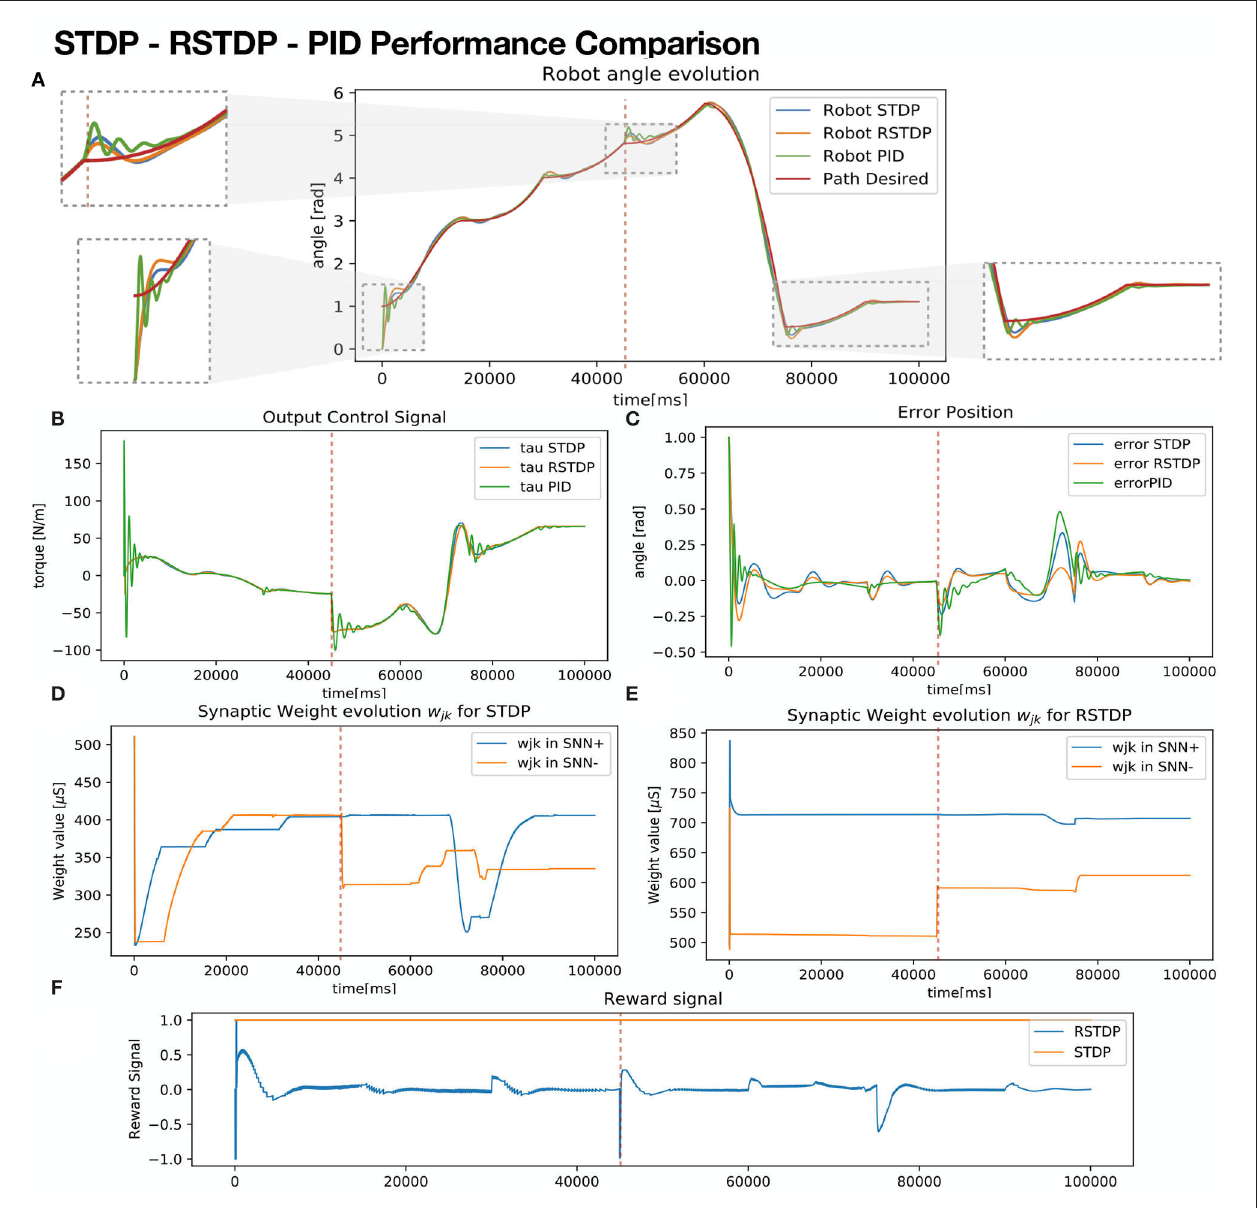
FIGURE 6 | 1-Link robot controller performance comparison. (A) Robot Angle evolution for each robot, SNN-RSTDP: with R jk = tanh ¨ q e (Yellow), SNN-STDP: proposal with R jk = 1 (Blue), PID-Controller tuned with Ziegler Nichols (Green), compared against reference (Red). (B) Control output of each controller. (C) Error position: difference against the reference. (D) Synaptic weights evolution for constant reward robot (SNN-STDP). (E) Synaptic weight evolution for the rewarded robot (SNN-RSTDP). (F) Reward signal for both SNN proposals.